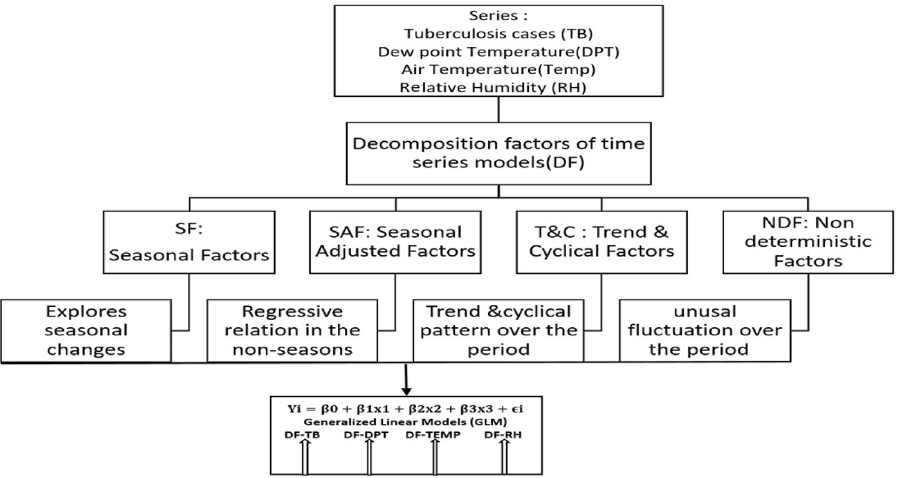
Figure 4. Schematic analysis flow of GLM for the decomposition factor of the time series model. Method : organigram of analytical methodology. Results : The decomposition procedure and GLM analysis are